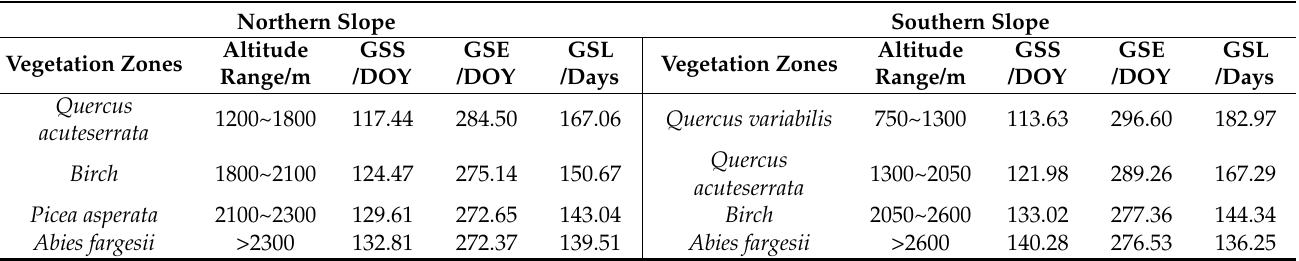
Table 1. Multi-year mean of vegetation phenological parameters on the different vegetation vertical zones in Niubeiliang Reserve from 2000 to 2017.